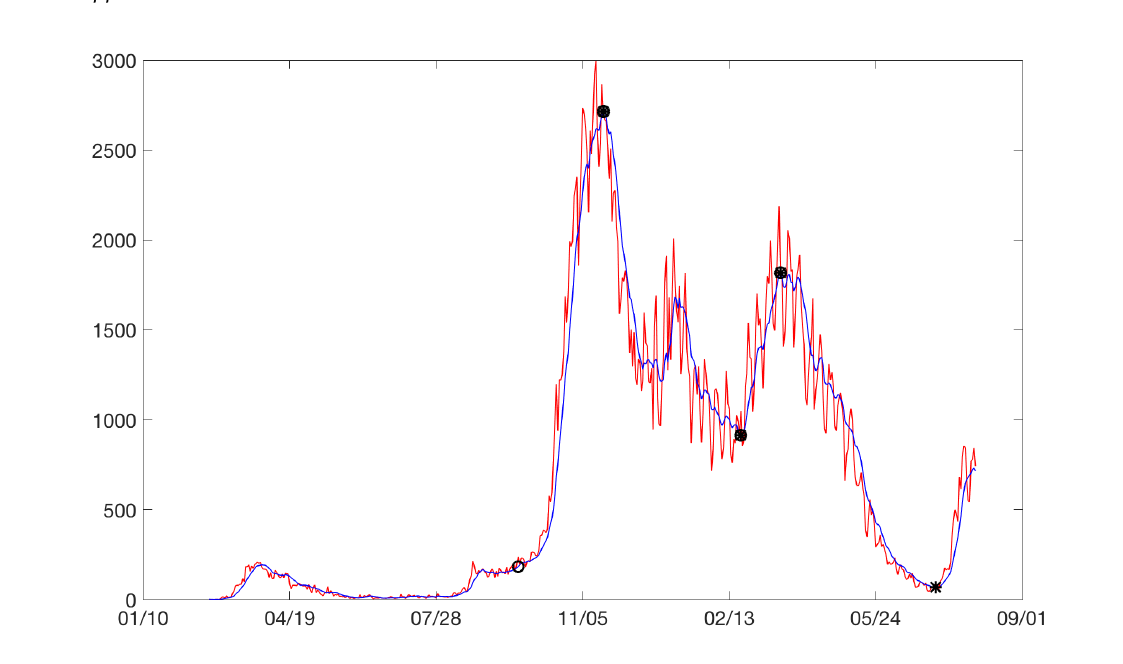
Figure A29. Roma: on the horizontal axis is the date in days and on the vertical axis are the daily